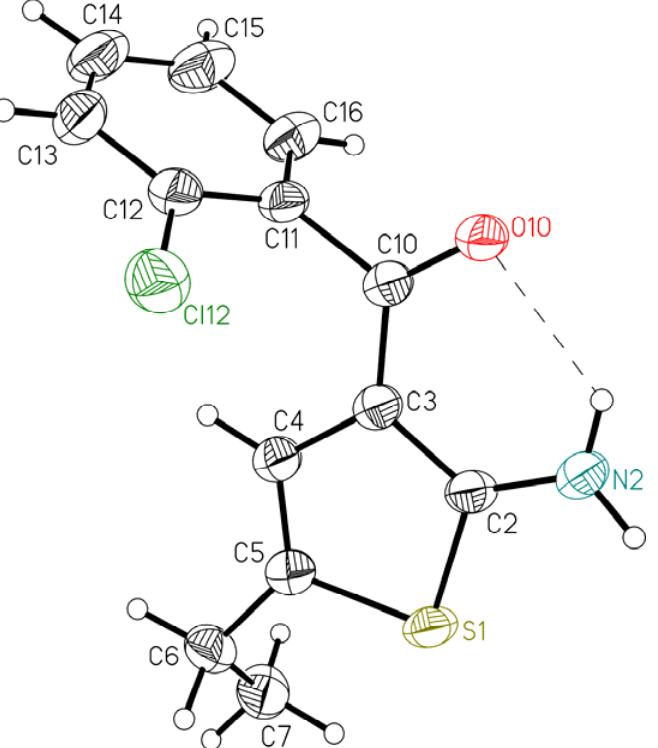
Figure 2. Ellipsoid representation of molecule 2 together with the atom labeling scheme [9]. The ellipsoids are drawn at 50% probability level, hydrogen atoms are depicted as spheres with arbitrary radii. The intramolecular hydrogen bond is drawn as a dashed